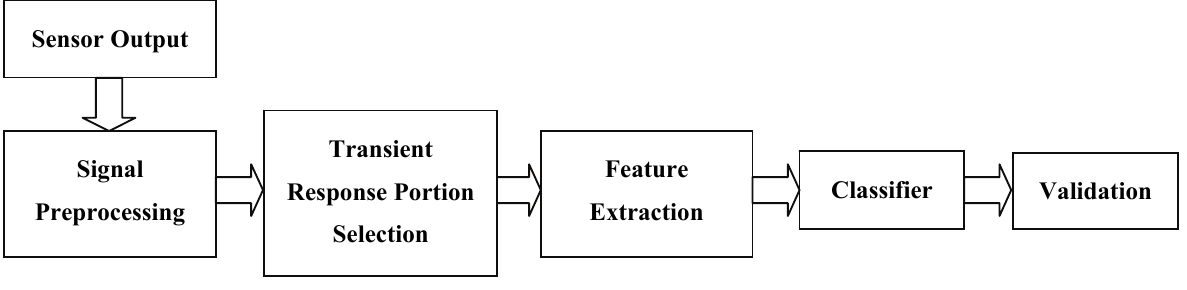
Figure 3. Flow diagram of processing method